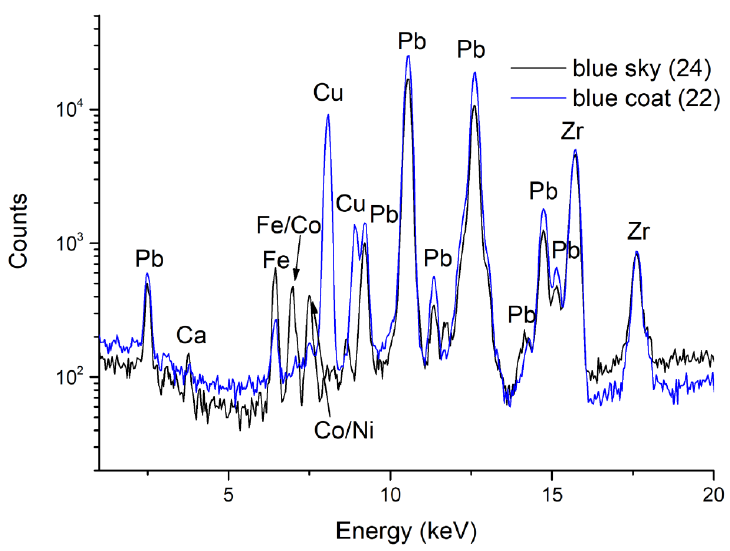
Figure 8. Comparison of two XRF spectra from blue areas reveal the use of azurite (Cu) for the Virgin’s coat (blue line), and smalt (K, Co, Ni, As) for most of the background (black line). Smalt is identified by common peaks of K, Ni, Co, and As; the high amount of Ni